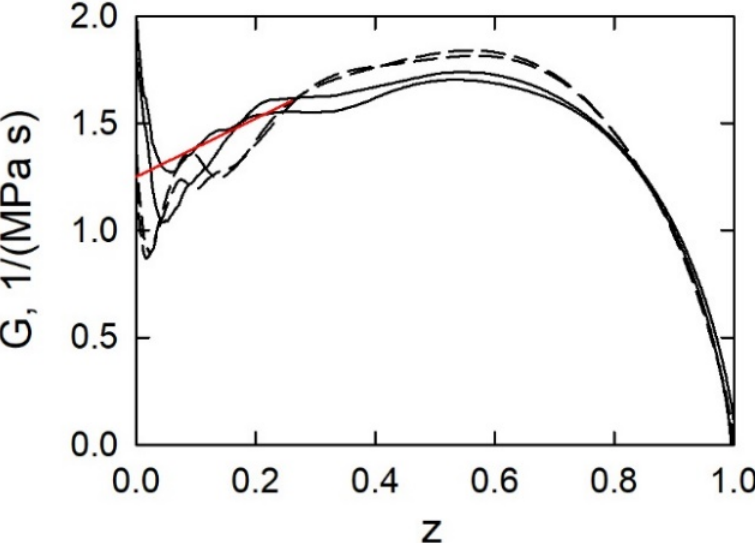
Figure 4. Estimated dynamic vivacity function as the function of relative burning propellant mass for loading density of 100 kg/m 3 (solid line) and 200 kg/m 3 (dashed line).